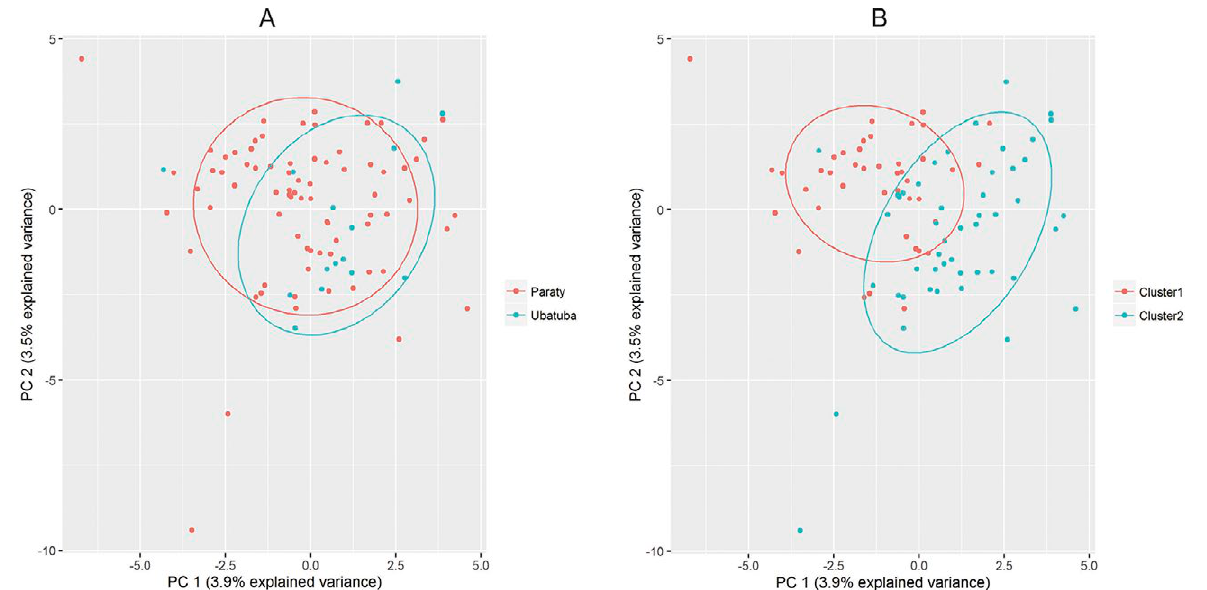
Fig. 3. – Dispersion plots of the first (PC1) and second (PC2) principal components based on the analysis of 91 individual C. undecimalis using 15 SSR loci. The ellipses, shown in different colours, represent the analysed individuals in two different analyses. A, populations divided into two groups according to geographical area: Paraty and Ubatuba coasts; B, populations divided into two groups according to the clusters identified using